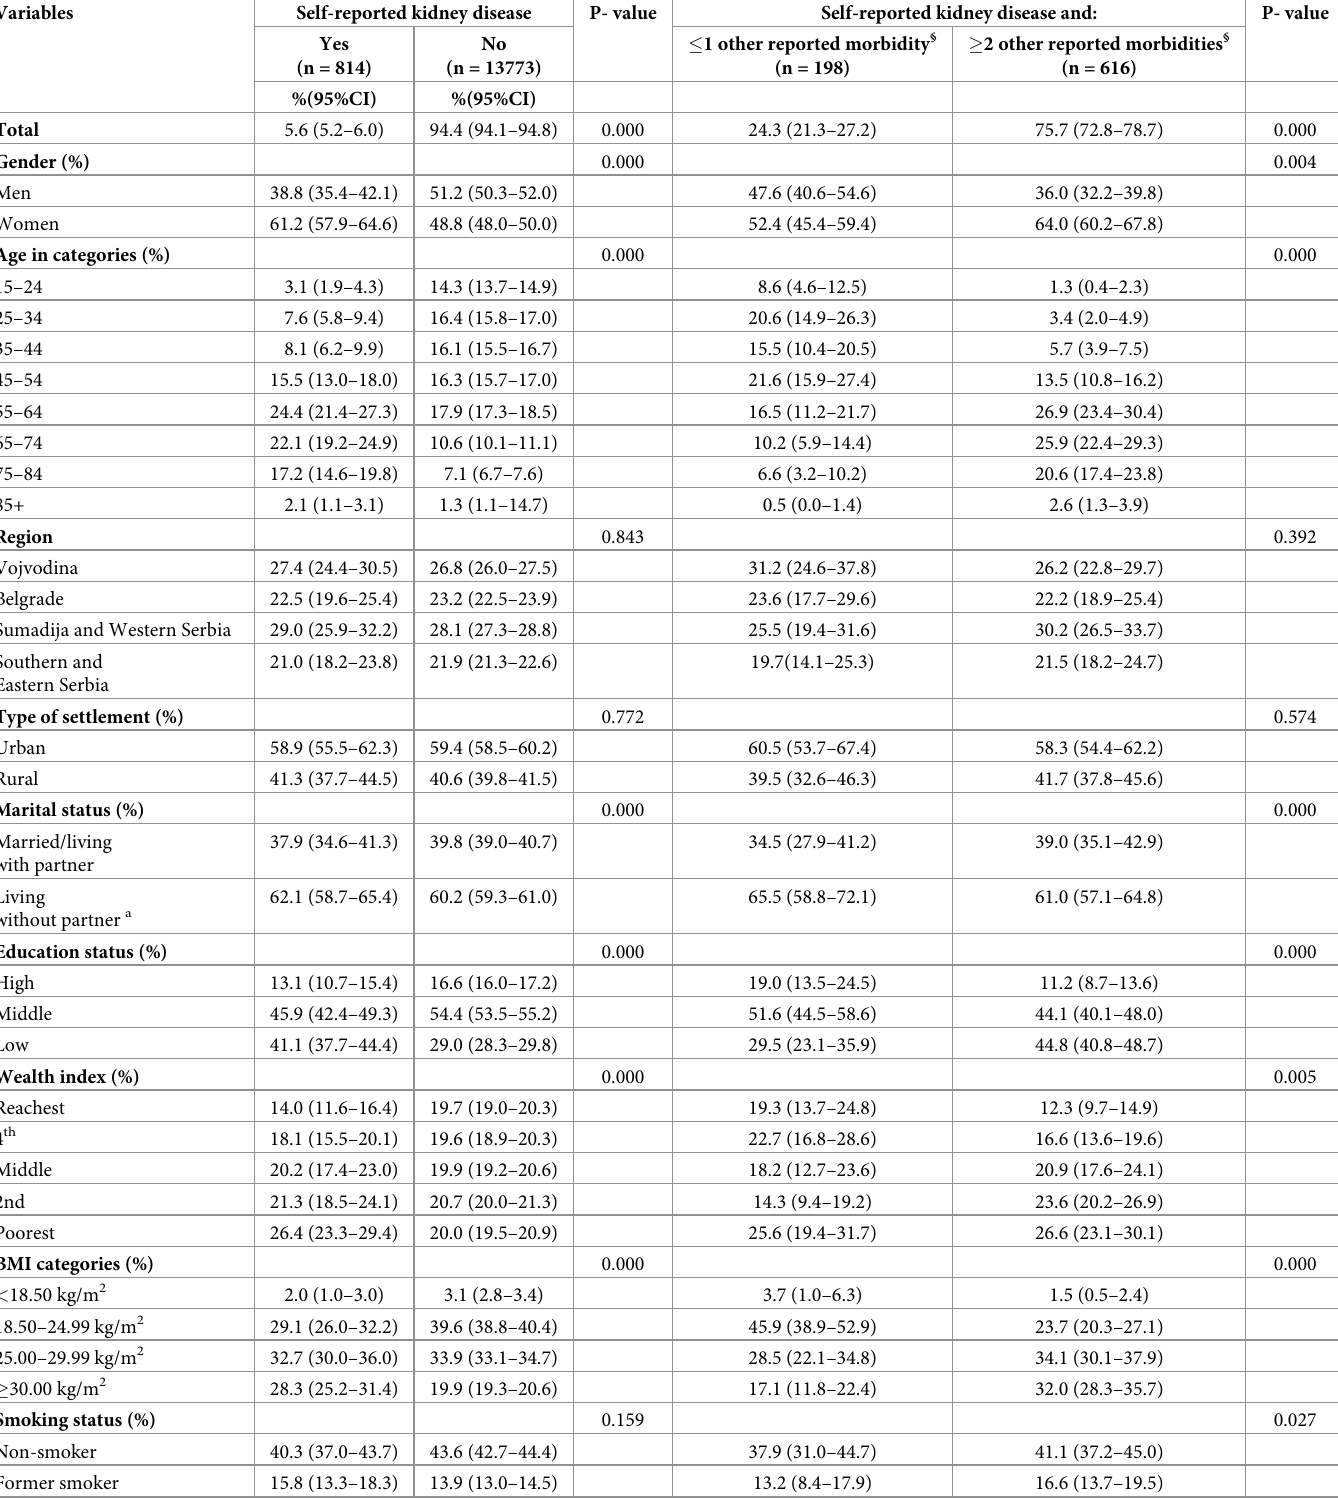
Table 1. Demographic, socio-economic and lifestyle characteristics of respondents, Republic of Serbia,